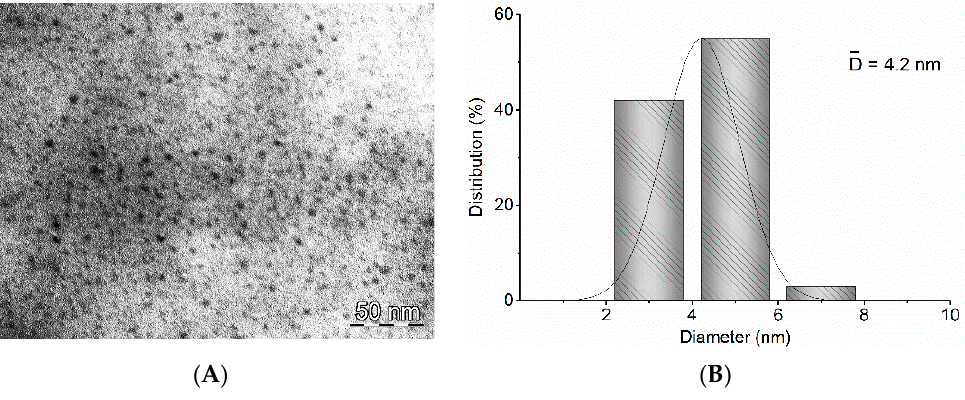
Figure 3. TEM image ( A ) and sizes histogram of NC(Cu-PVI) ( B ).